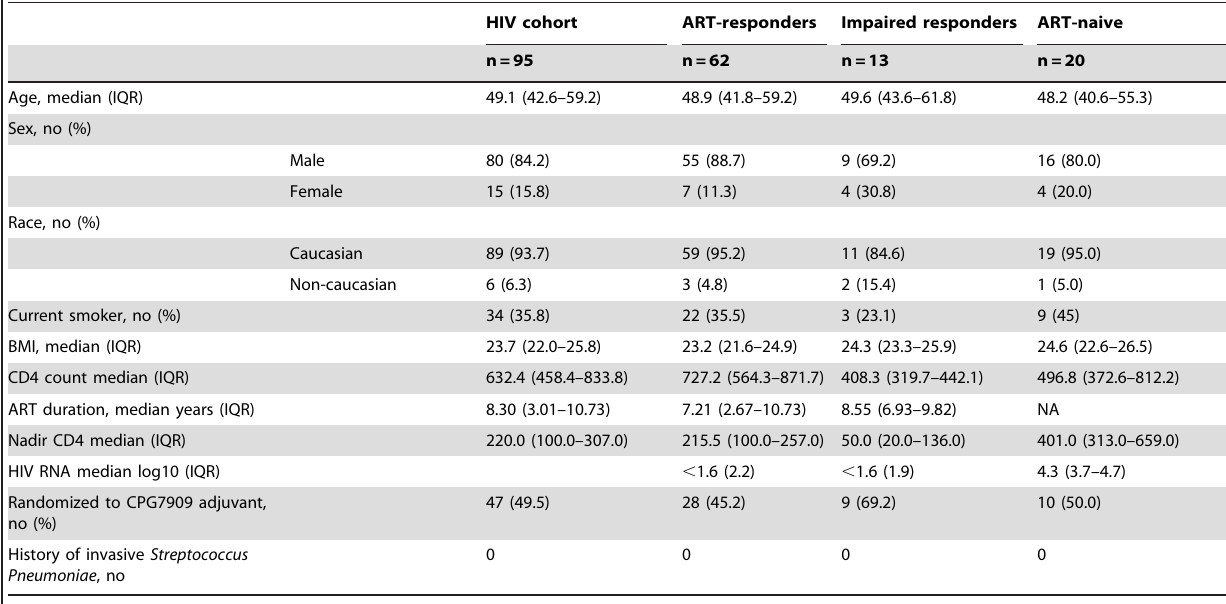
Table 1. Baseline characteristics of the study population at the time of inclusion.